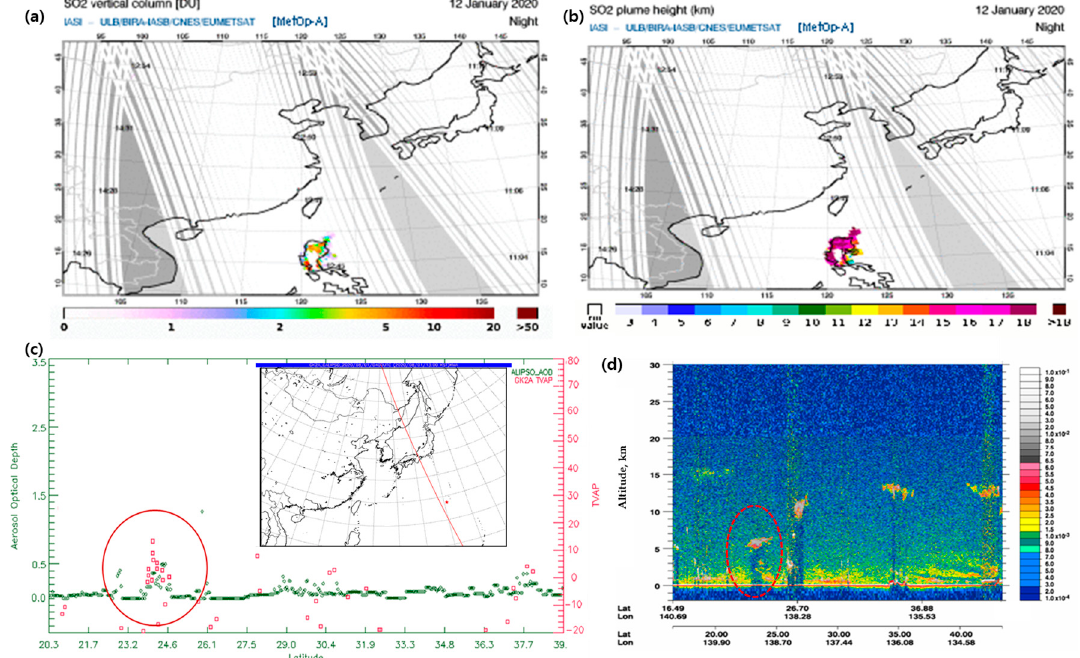
Figure 10. Images of MetOp-A/IASI for the Taal volcano eruption on 12 January 2020 ( a , b ), and Cloud-Aerosol Lidar and Infrared Pathfinder Satellite (CALIPSO) for the Nishinoshima volcano eruption at 04:06 UTC on 1 August 2020 ( c , d ). ( a ) SO 2 vertical column and ( b ) SO 2 plume height of MetOp-A/IASI provided by the Aviation Control Service (SACC: https: //sacs.aeronomie.be/nrt/) (accessed on 10 February 2021). ( c ) Analysis of the AOD of CALIPSO (Column Optical Depth Aerosols 532 nm) and TVAP of GK-2A after collocations when the CALIPSO satellite passed through the Nishinoshima region (marked by the red circle) and ( d ) 532 nm total attenuated backscattering (marked by the red dotted circle) from